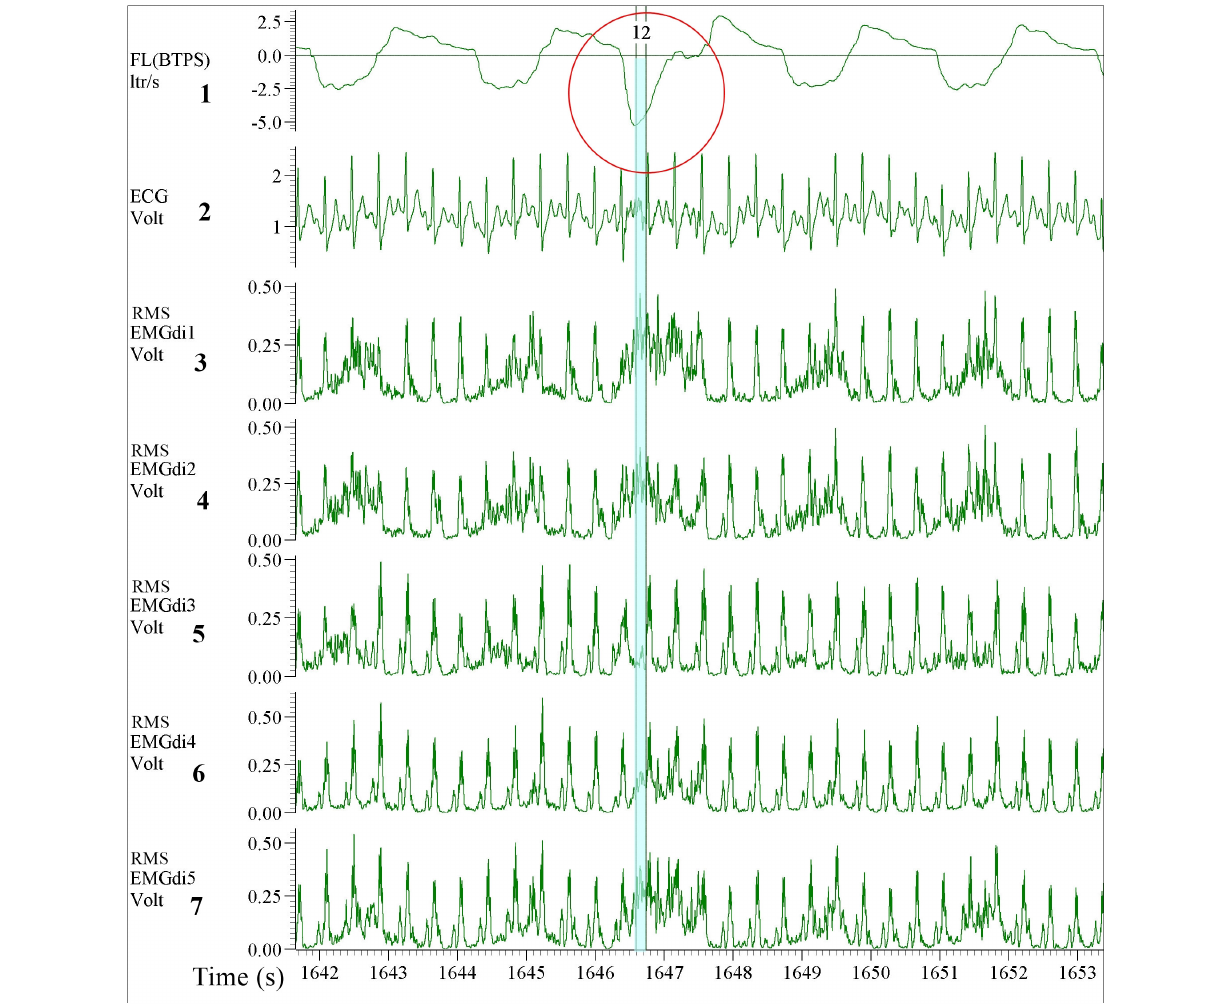
FIGURE 11 | Example of EMGdi recordings during a cycling exercise toward the end of the (symptom limited) cycling test for the analysis using the manual method. Channel 1: respiratory flow (l/s; negative flow indicating the inspiratory cycle), Channel 2: ECG recording (volt), Channels 3–7: Diaphragm EMG (RMS EMGdi) recordings. The IC maneuver is highlighted in the red circle indicated by the higher flow, which accompanies the maximal activation of the EMGdi. The periods highlighted in light blue are the periods that could be chosen without ECG contamination in an inspiratory cycle during IC maneuver. With the short inspiratory time during the IC maneuver, it left only one available (light blue) period that EMGdi could be